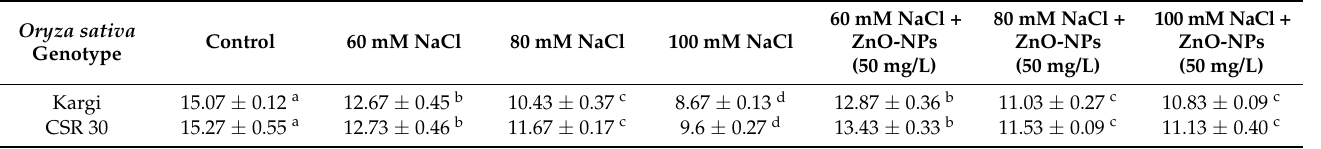
Table 1. Effects of ZnO-NPs on Oryza sativa seedling height (cm) of Kargi and CSR 30 genotypes under salinity stress